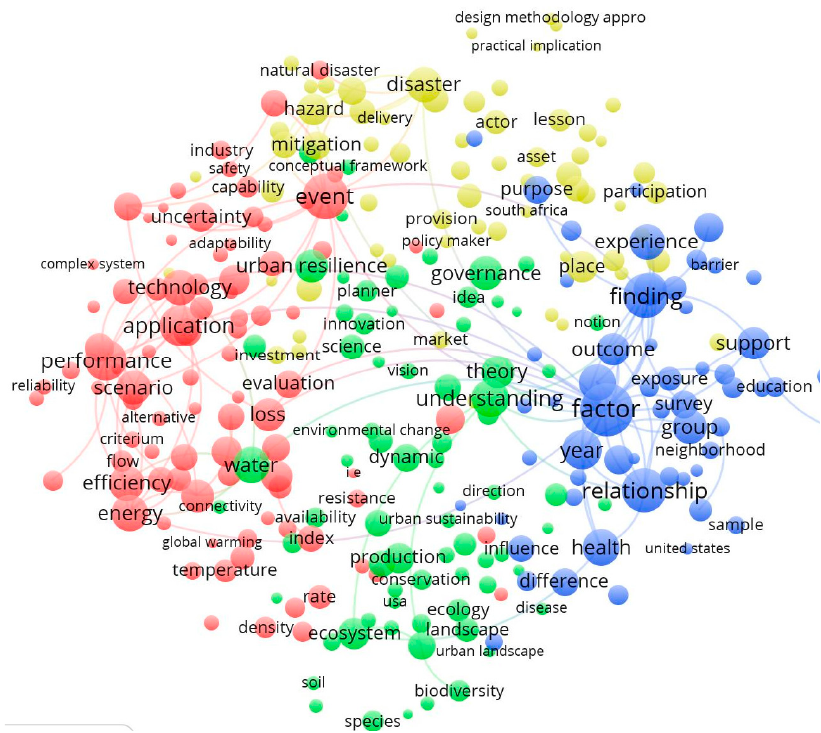
Figure 1. Term map representing the main research areas on resilience in the built environment.